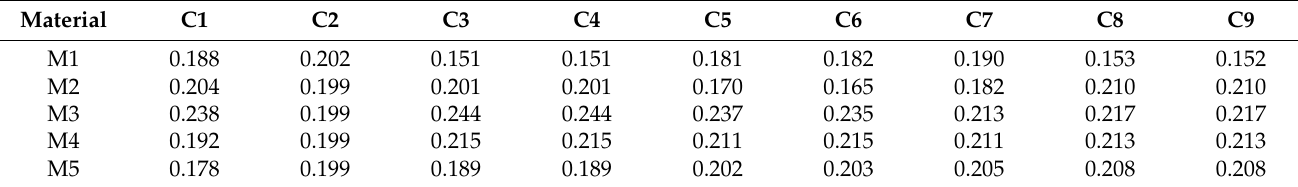
Table A8. Normalized COPRAS decision matrix (AHP).